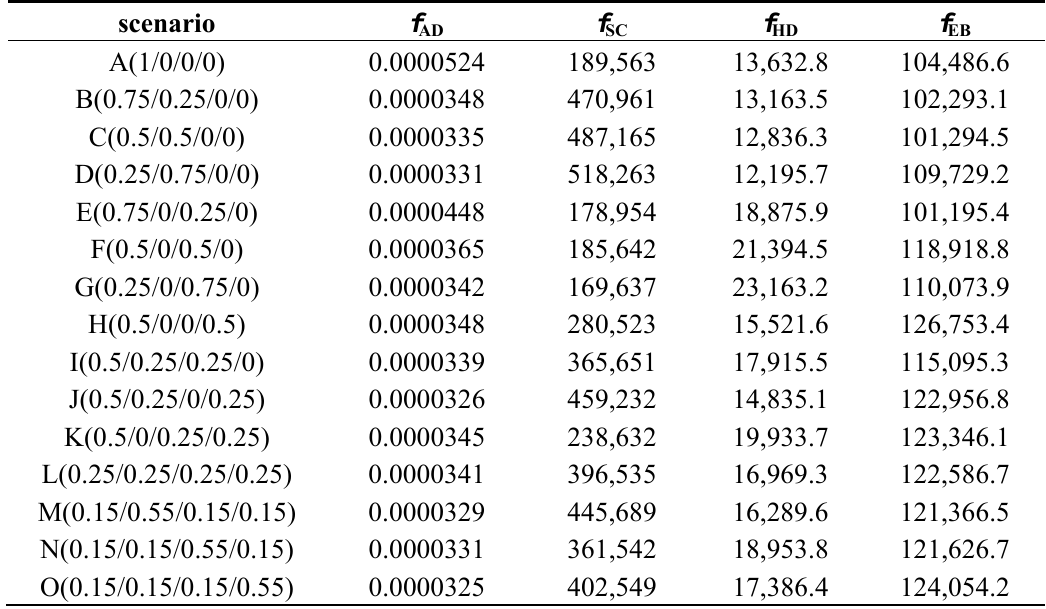
Table 9. The value of the four sub-objectives in the various weighted